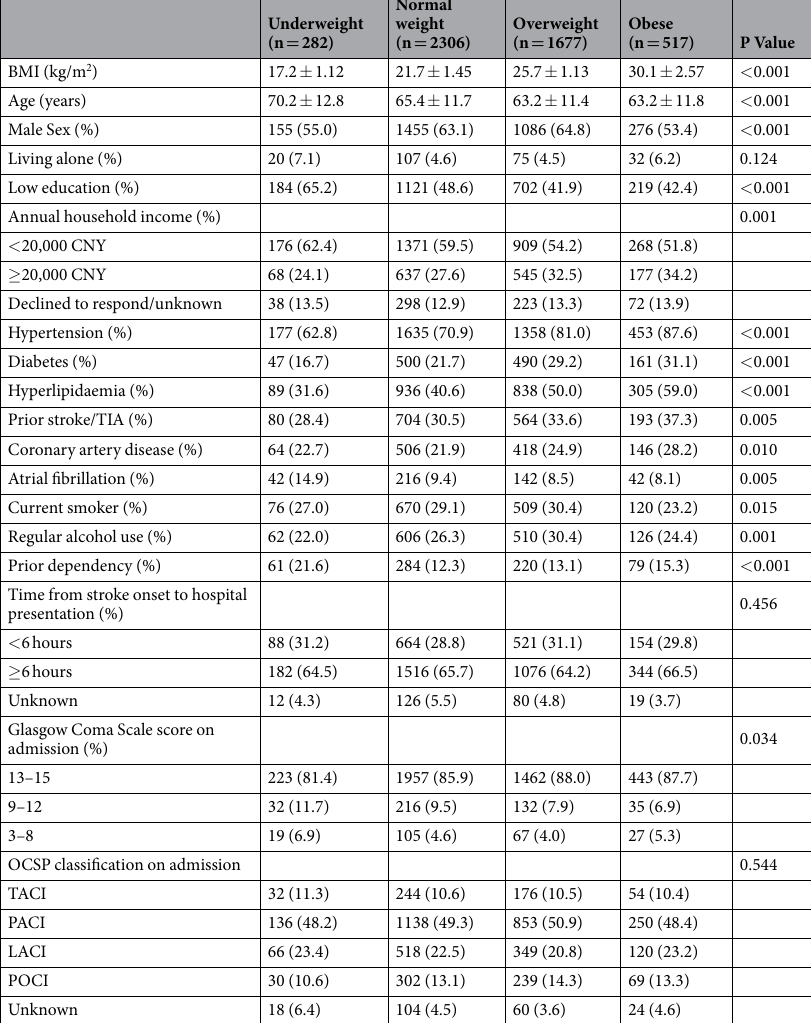
Table 1. Baseline characteristics by body mass index subgroup. BMI, body mass index; CNY, Chinese Yuan; LACI, lacunar infarct; OCSP, Oxfordshire Community Stroke Project classification; PACI, partial